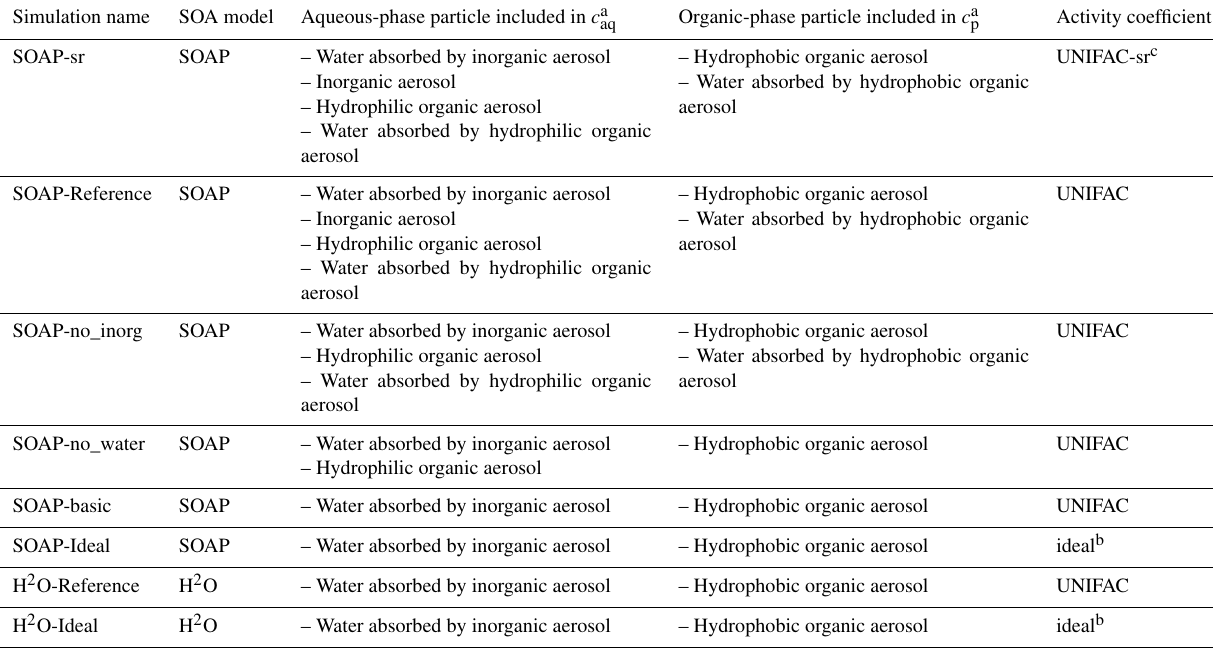
Table 2. List of the sensitivity simulations to compare the H 2 O and SOAP models.